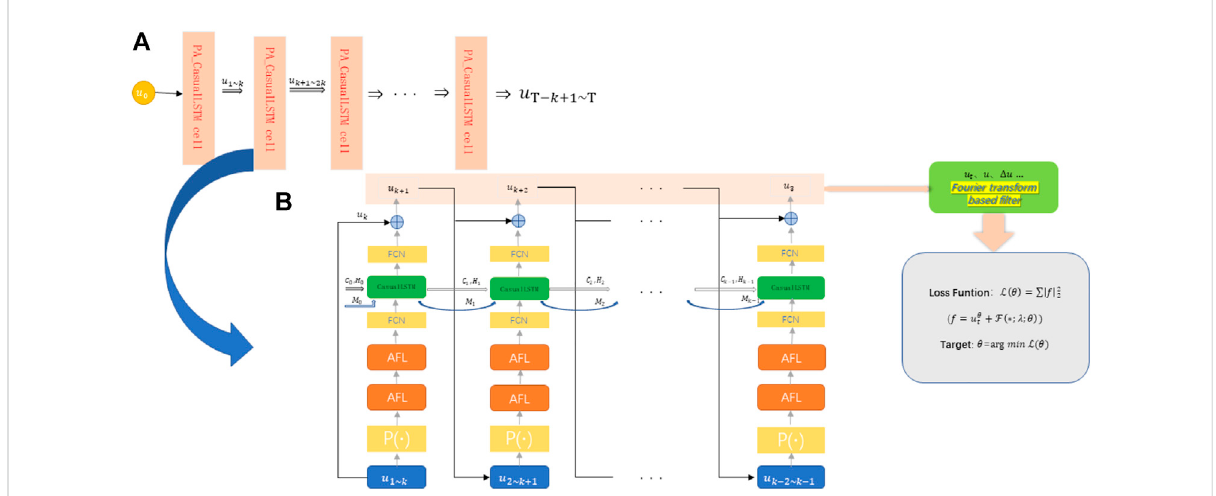
FIGURE 2 (A) The network structure of PA_CasualLSTM. It is an adaptive time marching strategy composed of the PA_CasualLSTM cell. After the current group is trained, some training results are taken as the input of the next stage; (B) The network structure of PA_CasualLSTM cell. H, C, and M are the hidden state, temporal memory, and spatial memory of CasualLSTM. θ needs to be acquired by training the